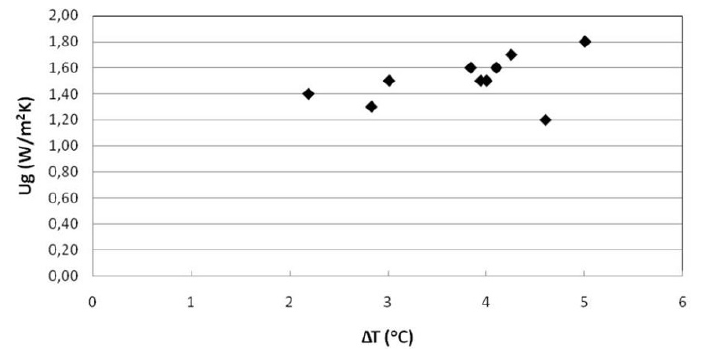
Figure 11. Variation of U g versus temperature difference ∆ T . Scenario 1 .